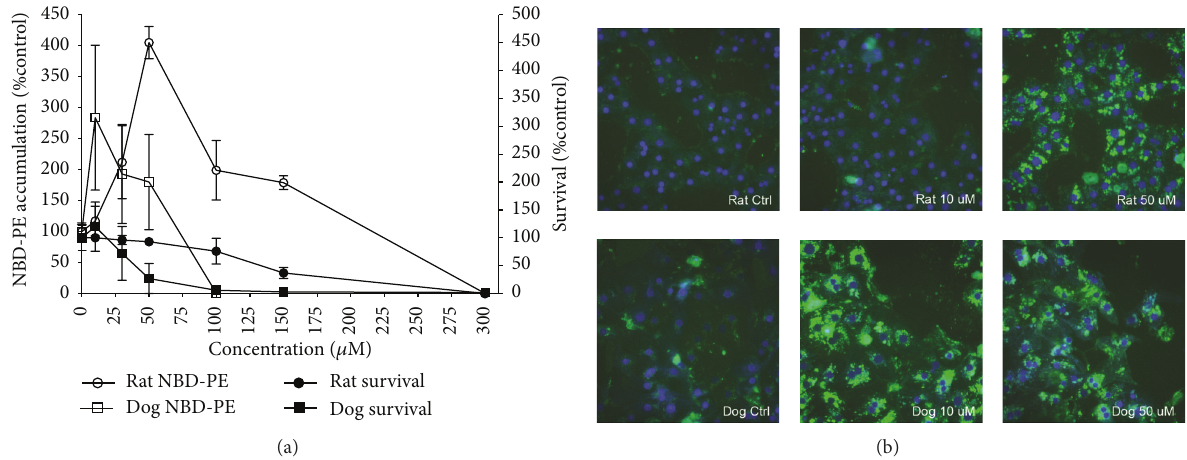
Figure 2: (a) Differential effect of NMTMB on survival and NBD-PE accumulation in dog and rat hepatocytes. Cells were treated with compound in NBD-PE containing media. After 24 h cells were fixed with formaldehyde/Hoechst, and both survival and NBD-PE accumulation were quantified using the Cellomics Arrayscan instrument (as described in Section 2). Expressed as % control ± SD for 3 replicates from single isolations. Dog and rat hepatocytes were isolated for this experiment on the same day. (b) Differential effect of NMTMB on accumulation of NBD-PE in rat and dog hepatocytes. Cells were treated with NMTMB in NBD-PE containing media. After 24 h cells were fixed with formaldehyde/Hoechst and imaged using the Cellomics Arrayscan instrument. Image exposures were identical in all experiments (0.5sec);backgroundlevelsofNBD-PEaccumulationweresimilarbetweendogandrathepatocytes(approximately50meanaverageintensity units). Some artifactual accumulation of NBD-PE in dog preparations is apparent in the control sample. Dog and rat hepatocytes were isolated for this experiment on the same day.